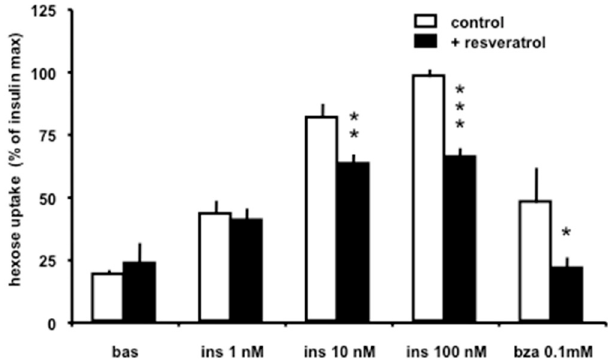
Figure 3. Inhibition of the insulin- or benzylamine-induced activation of glucose uptake in Swiss mouse adipocytes by resveratrol. Fat cells were incubated for 45 min without (basal, bas) or with increasing concentrations of insulin (ins), or with 100 µ M benzylamine (bza), in the absence (control) or in the presence of 100 µ M trans-resveratrol (plus resveratrol, black columns). Data are expressed as the percentage of the maximal stimulation of glucose uptake by 100 nM insulin alone, which was not altered by the DMSO vehicle present in control conditions (open columns). Each column is the mean + SEM of 8–16 observations. Significantly different from corresponding control at: * p < 0.05; ** p < 0.01; *** p < 0.001, by paired t test.